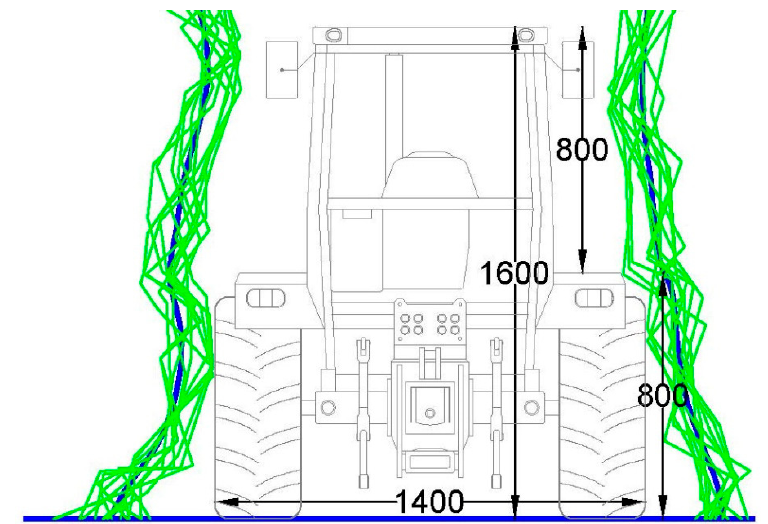
Figure 4. Guyot vineyard (located in Cellino San Marco, Brindisi Province, Southern Italy). Set of splines (green lines), characteristic contour of the vineyard canopy (blue line) and hypothetical size of the compact tractor (sizes in mm).